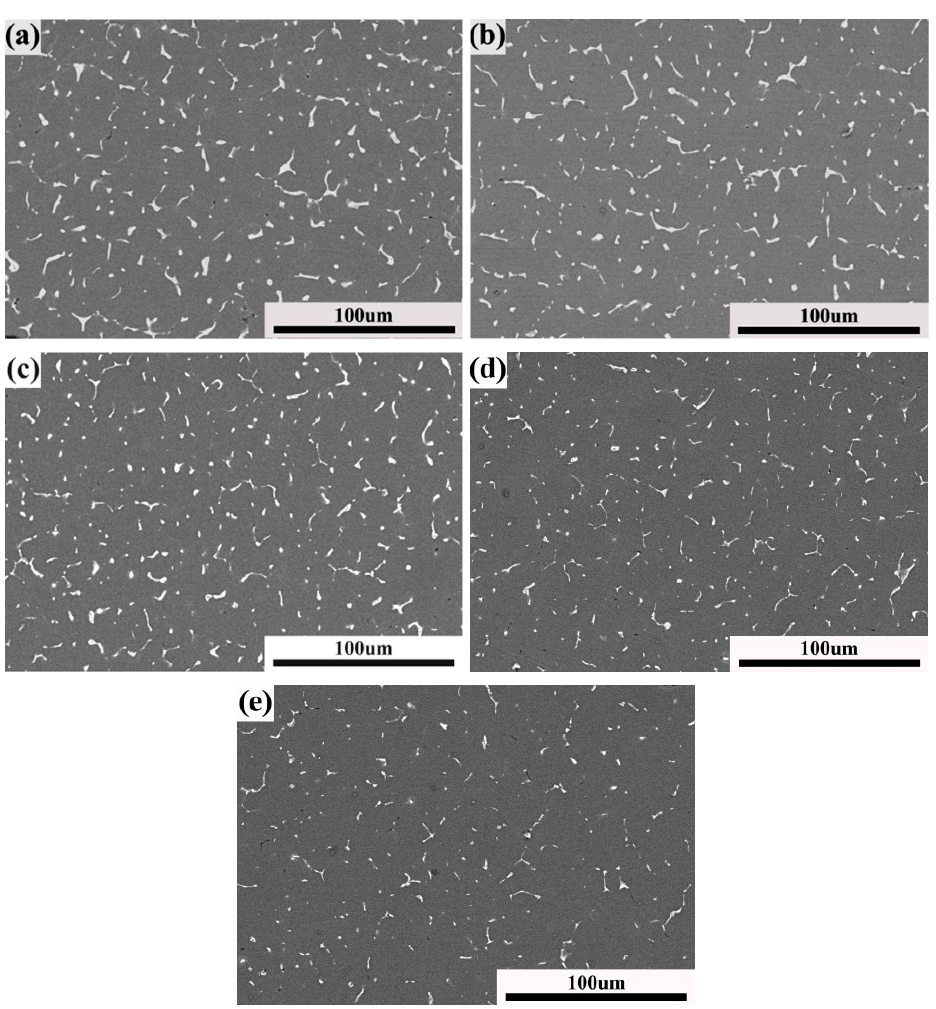
Figure 5. BSE micrographs of welded joints after PWHT with solution at different temperatures for 60 min followed by aging at 120 °C for 24 h: ( a ) 460 °C; ( b ) 470 °C; ( c ) 480 °C; ( d ) 490 °C; and ( e ) 500 °C.